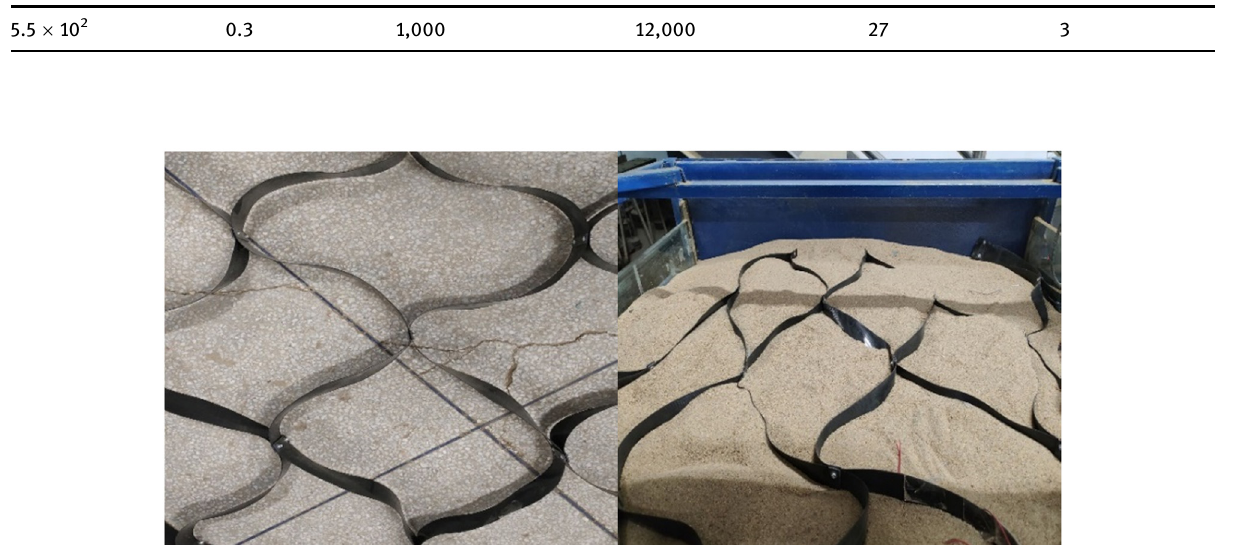
Figure 3: Schematic diagram of the geocell and its laying